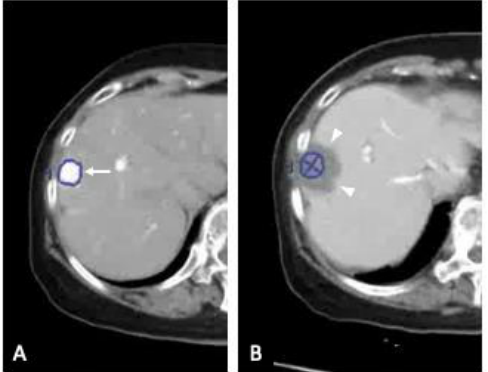
Figure 1. Good response after radiofrequency ablation (RFA). ( A ). Early-phase dynamic CT scan shows hepatocellular carcinoma (HCC) as an enhanced lesion (arrow) in segment 8 of the liver. The tumor border is marked with a thick blue line. ( B ). The traced tumor border is projected on to the low-density ablation zone (arrow heads) by the use of an overlay fused fusion